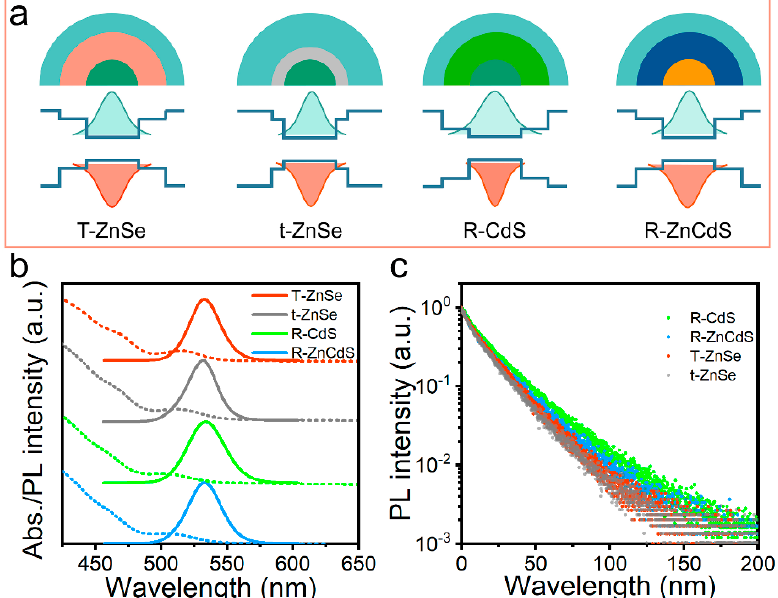
Figure 1. ( a ) Schematic illustration of the nanostructure and wave function confinement properties of rich CdS (R − CdS), thick ZnSe (T − ZnSe), thin ZnSe (t − ZnSe) and ZnCdS (R − ZnCdS) intermediate transition shell quantum dots. ( b ) Photoluminescence (PL) spectra and ( c ) PL decay dynamics of R − CdS, T − ZnSe, t − ZnSe, and R − ZnCdS corresponding quantum dots, respectively. Table 1. PL decay for R-CdS, T-ZnSe, t-ZnSe and R-ZnCdS quantum dots; the nonradiative recombi- nation decay component and its proportion ( τ 1 and f 1 ); the radiative recombination component and its proportion ( τ 2 and f 2 ); and the corresponding lifetime ( T